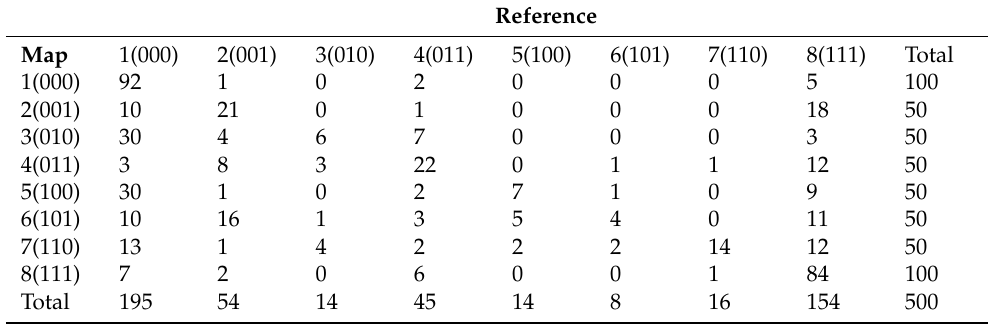
Table 7. The initial prediction error matrix (000 – 111 denote the three-phase urban land change and no-change types corresponding to Table 5).